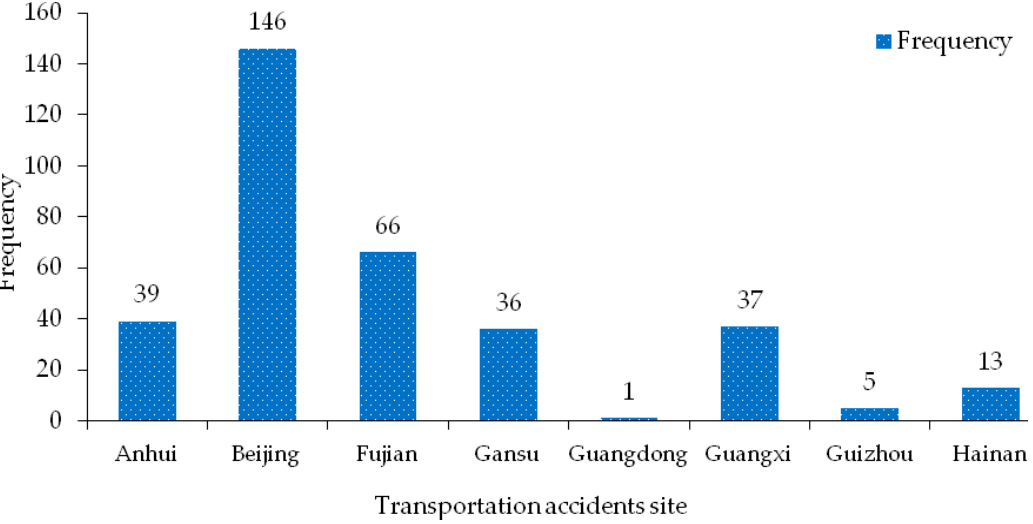
Figure 7. Road distribution characteristics of hazardous materials transportation accidents.